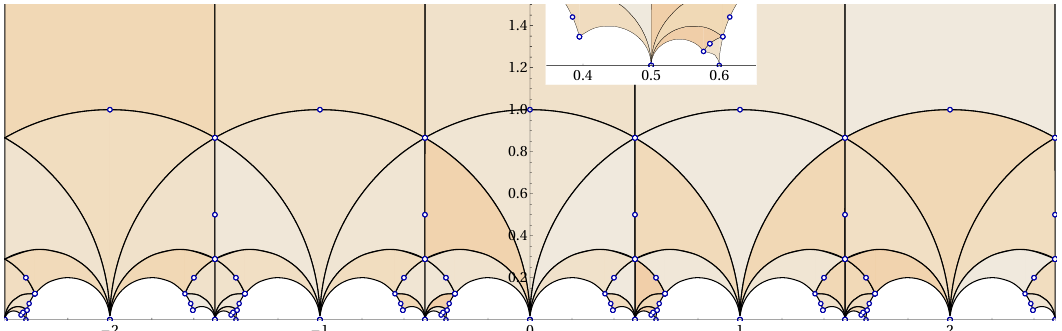
Figure 5 . The fundamental domain D (5) of ¯Γ(5) with the stabilisers of modular transformations of Γ 5 denoted as dots. In the box on top, we show a zoomed section of the domain around the cusp τ = 1 / 2 , where there are many small-sized intricacies. We show only one zoomed section as the remaining areas surrounding the half-integer cusps are